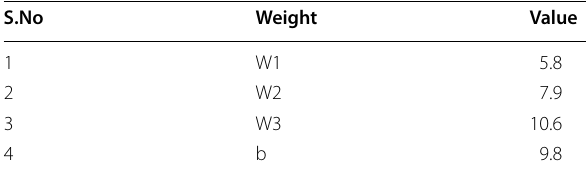
Table 14 DG size comparison under ANN and heuristic pdf